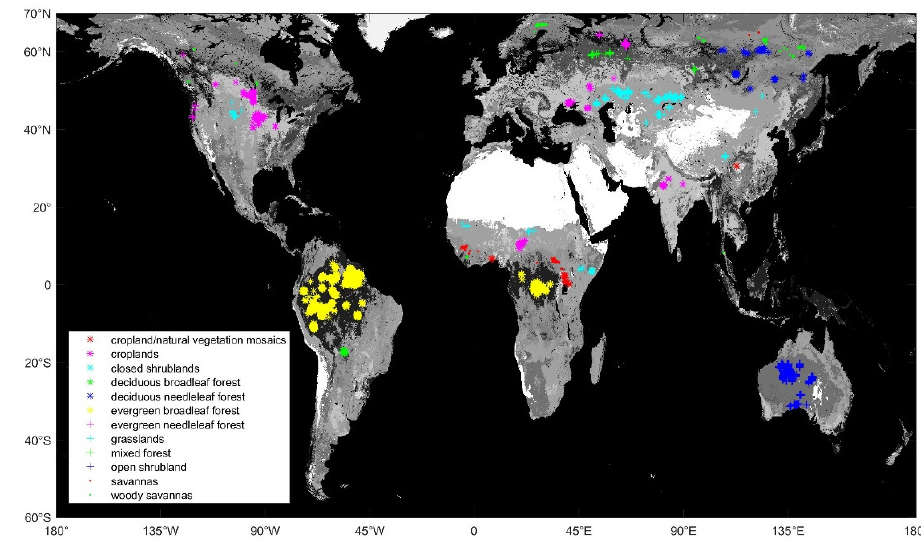
Figure 1. Global distribution of pure pixels for 12 vegetated land types.